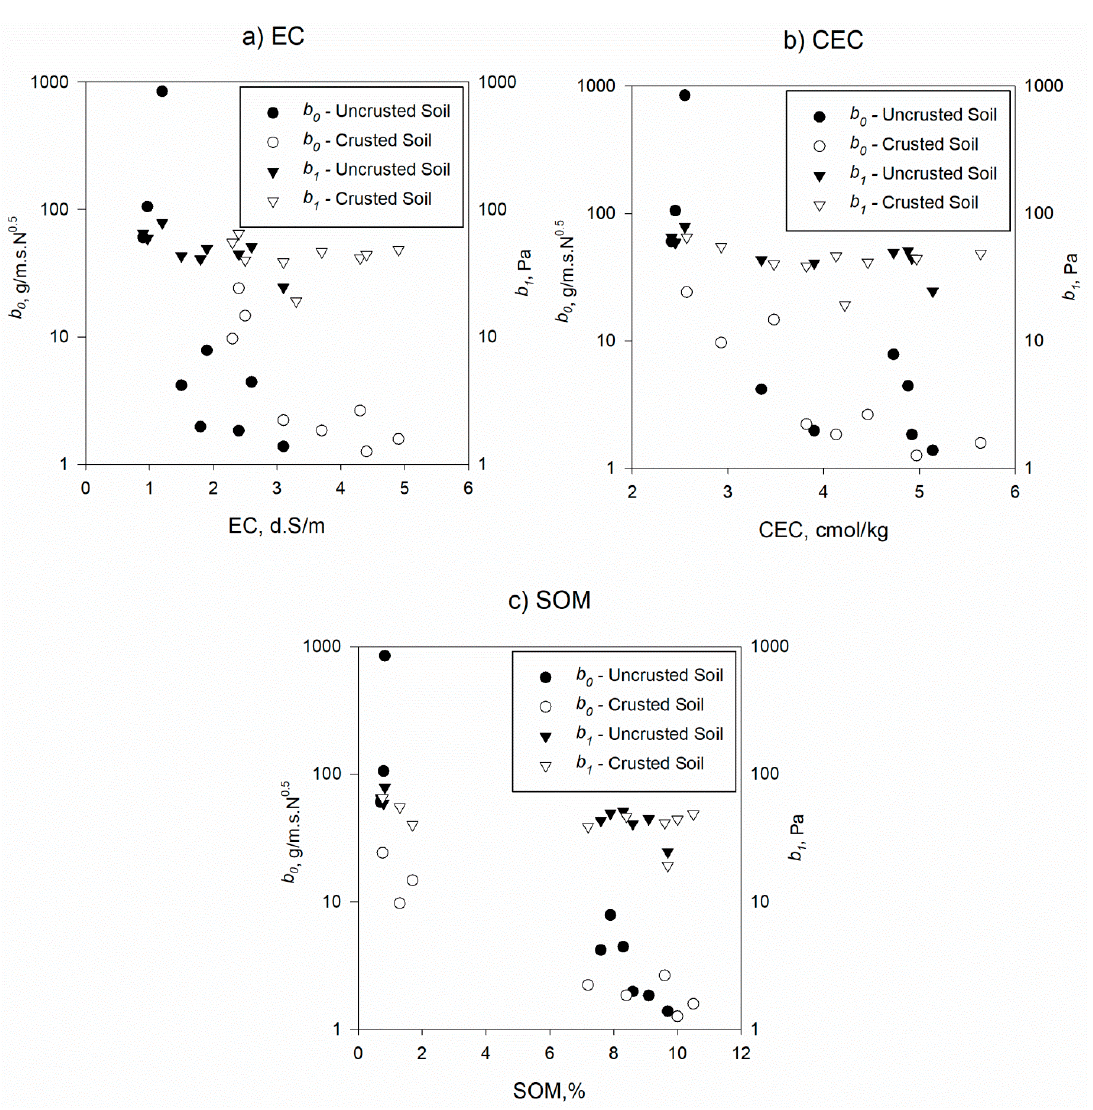
Figure 10. Relationships between mechanistic soil erodibility parameters ( b 0 and b 1 ) derived from JET experiments and ( a ) EC, ( b ) CEC, and ( c ) SOM that were performed on crusted and uncrusted soil samples with and without humic acids.